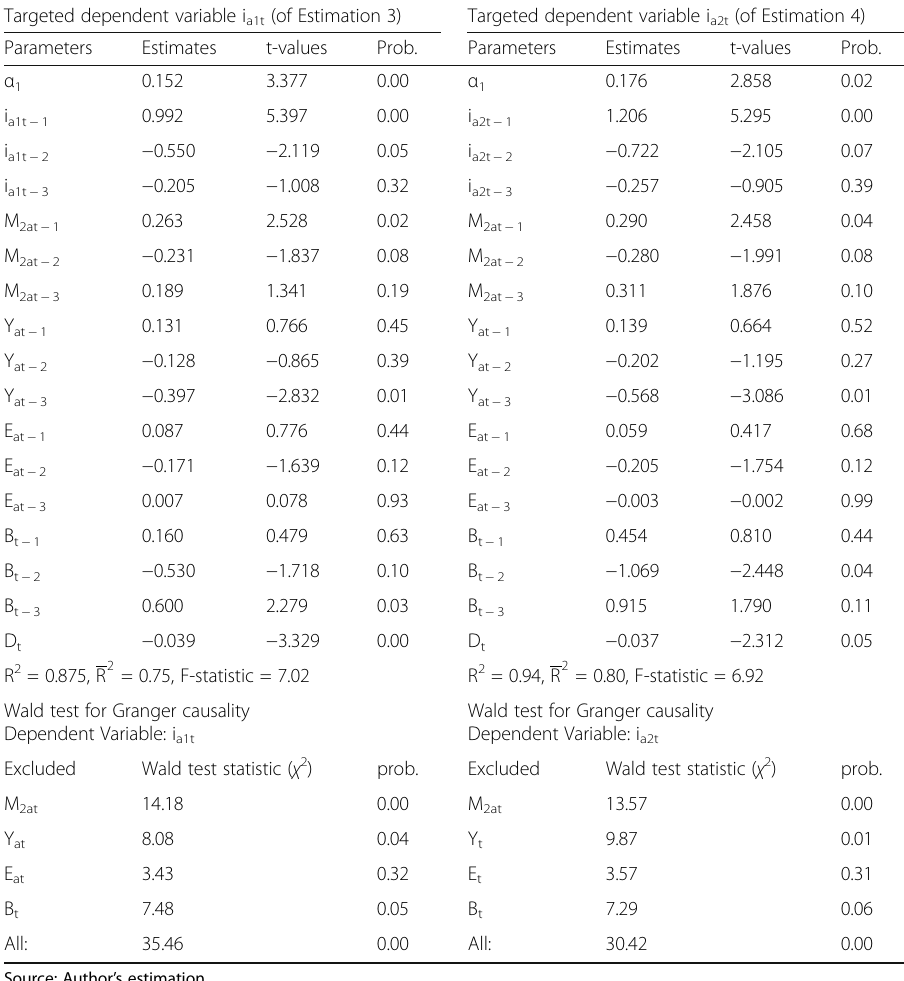
Table 4 Dynamics of annual interest rates (M2 money growth is used) Targeted dependent variable i a1t (of Estimation 3) Targeted dependent variable i a2t (of Estimation